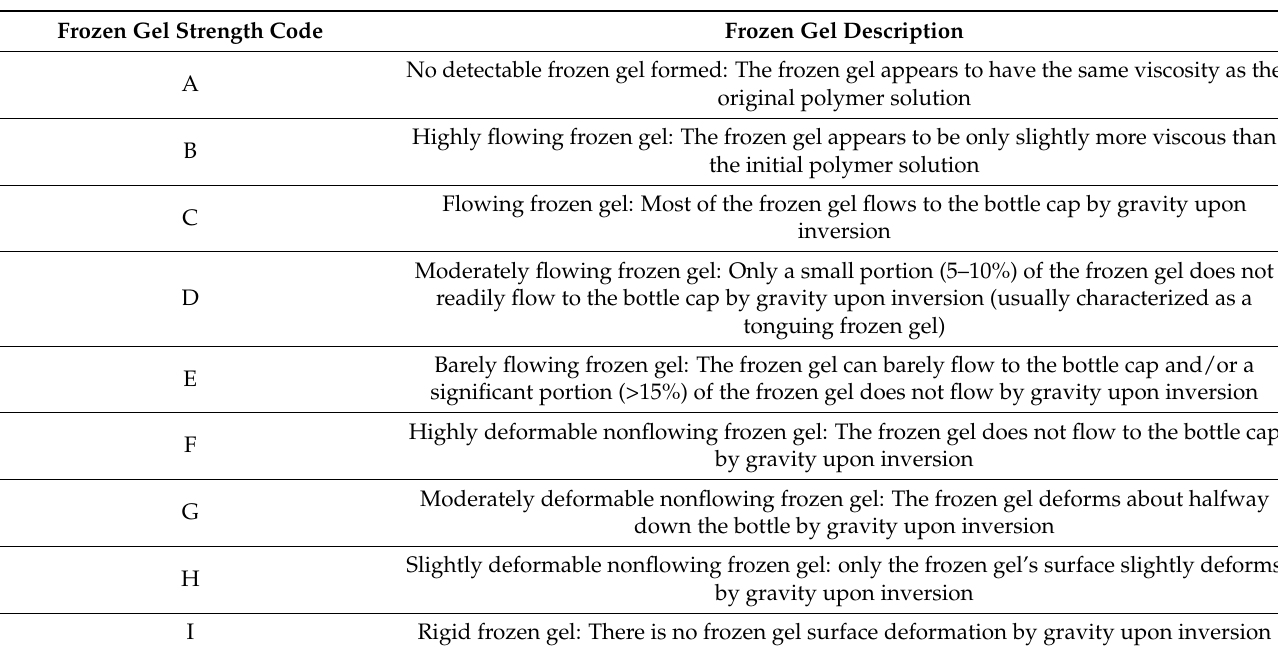
Table 2. Frozen gel strength codes